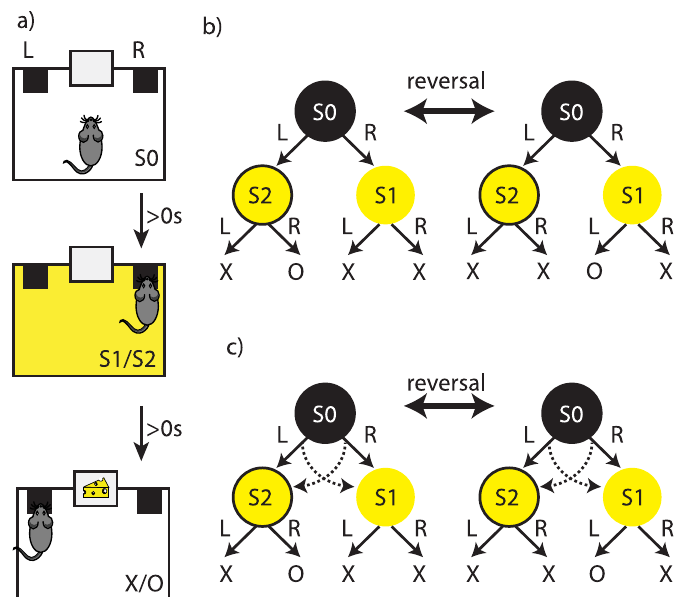
Fig 2. (a) The flow of events in the two-stage task. Trials started in state S0, which was signalled by the absence of the house light. After an action (‘L’ or ‘R’) was taken at stage 1, either constant or blinking house light started (S1 or S2). Next, subjects could take another action at stage 2 (‘L’ or ‘R’), which could lead either to the delivery of the outcome or to no outcome. Actions taken in S0 immediately lead to the presentation of either S1 or S2, and actions taken in S1 or S2 immediately lead to the outcome or no outcome. The inter-trial interval (ITI) was zero in this experiment, but in the experiments reported in the S5, S6 and S7 Figs it was greater than zero, as detailed in S2 Text. (b) The structure of the task. Stage 1 actions in S0 led to the stage 2 stimuli (S1/S2) in a deterministic manner. The rewarding stage 2 state changed with a probability of 0.14 after earning an outcome (indicated by ‘reversal’ in the graph). ‘O’ represents outcome, and ‘X’ no-outcome. (c) The structure of the probe sessions. The probe sessions were similar to the training sessions (panel (b)), except that stage 1 actions led to the stage 2 states in a probabilistic manner. Taking action ‘L’ led to state S2 commonly (80% of the time), and to state S1 rarely (dashed lines). Taking action ‘R’ led to state S1 commonly (80% of the time), and to state S2 rarely (dashed